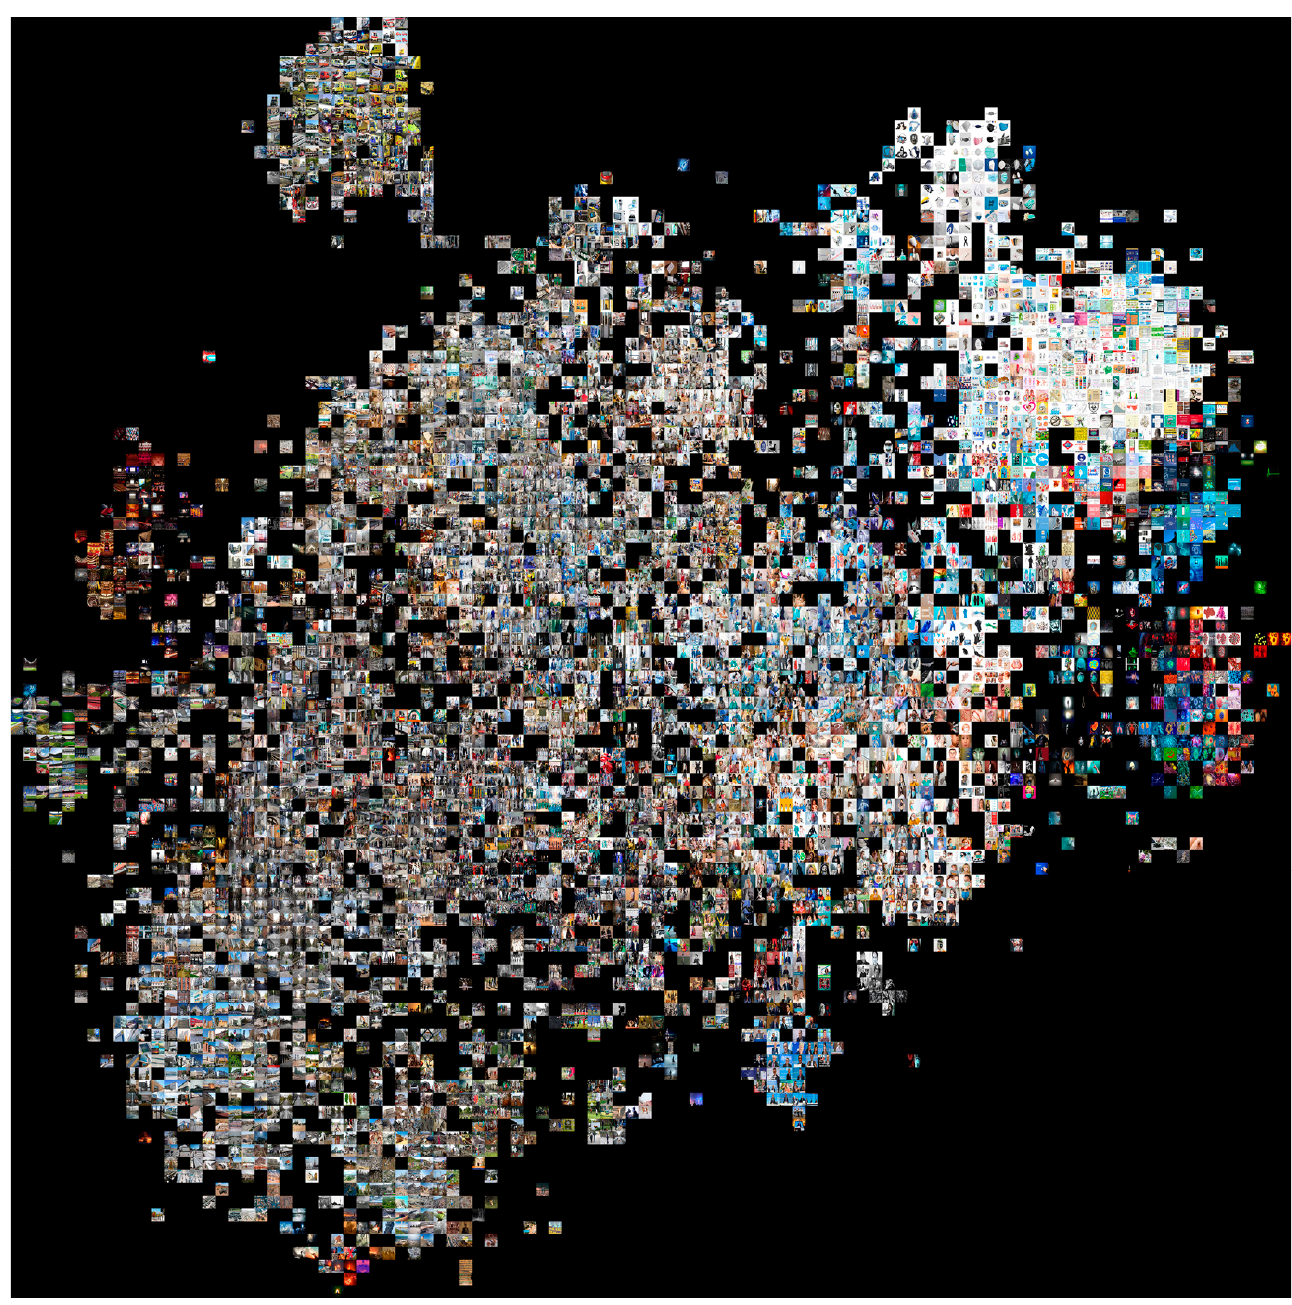
Figure 10. Digital image containing 10,000 images related to COVID-19 pandemic (2 × 2 m). © Pilar Rosado.